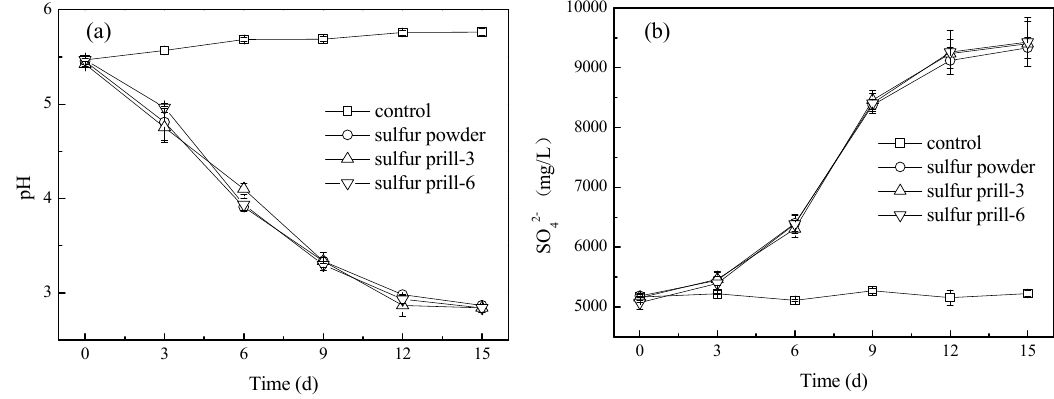
Figure 2. Variation of pH ( a ) and sulfate during bioleaching ( b ) with different sulfur forms.